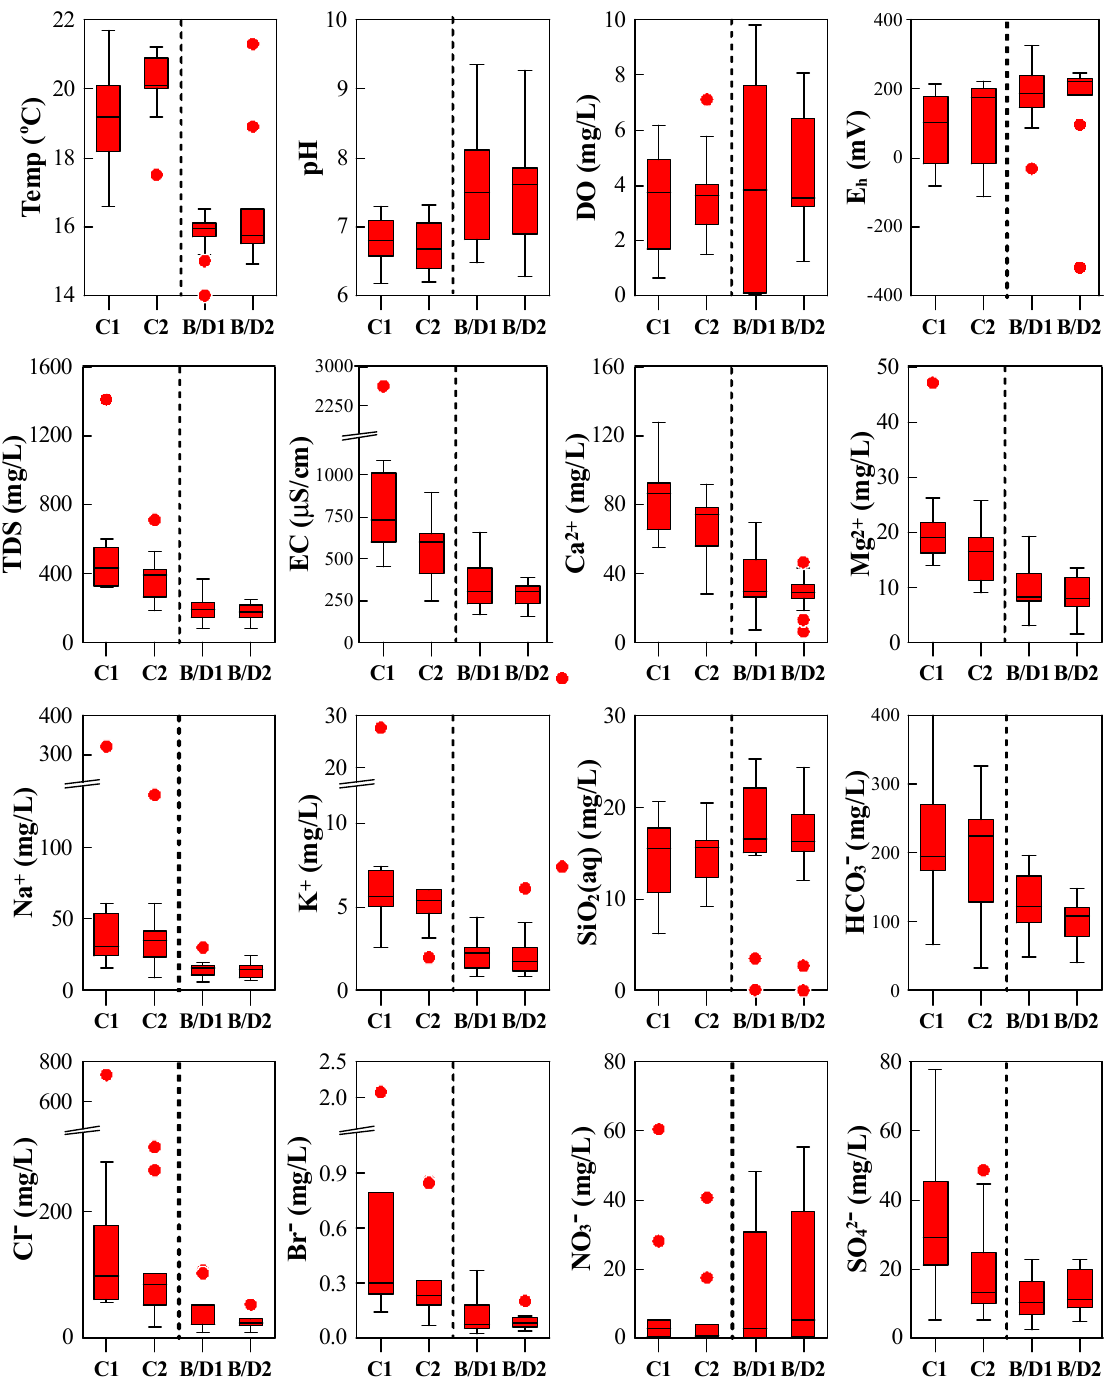
Figure 5. Box plots for groundwater quality changes indicating seasonal variations. X axes indicate group C and B/D of wells. Group C wells are installed mainly at shallow depths in the alluvial aquifer, and group B/D wells are installed deep in the bedrock. The first survey results in July 2019 of group C wells are marked as C1, and the second survey results in October 2019 as C2. Similarly, the first survey results of group B/D wells are marked as B/D1, and the second survey results as B/D2.